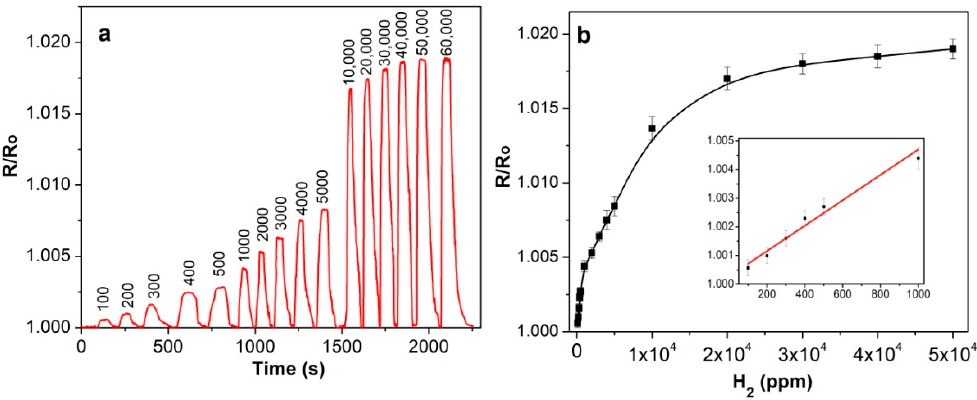
Figure 7. ( a ) Sensor response of SWCNT/SiPc layers toward NH 3 (1–50 ppm) measured at RH 5% and 25 °C; ( b ) dependence of the sensor response of SWCNT/SiPc and pristine SWCNT on ammonia concentration.